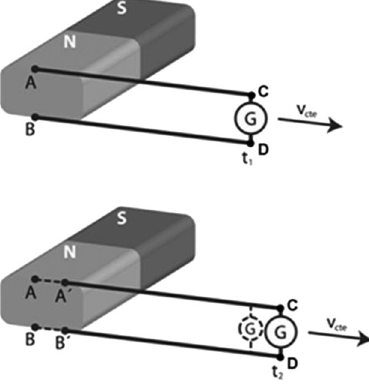
FIG. 4. Experimental setup in the laboratory of activity A.19.